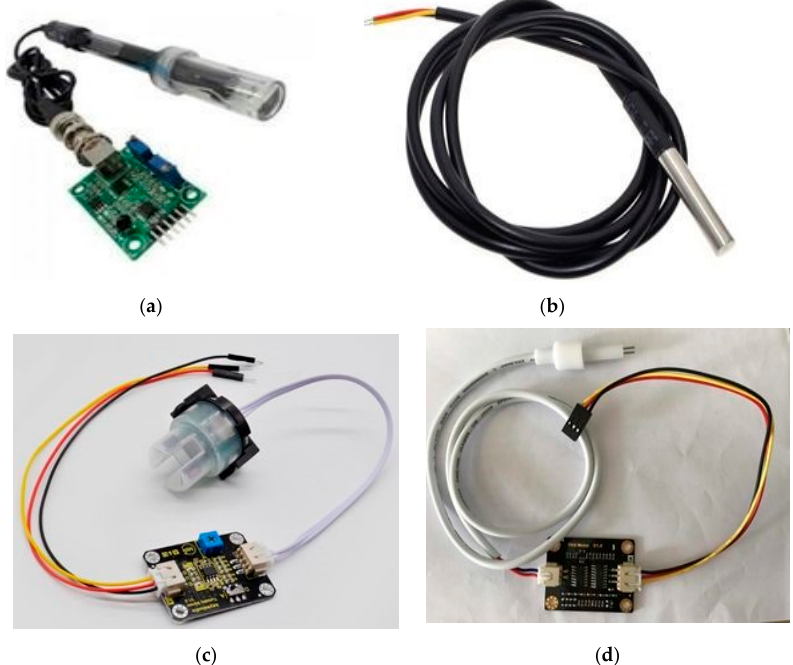
Figure 3. ( a ) pH sensor, ( b ) temperature sensor, ( c ) turbidity sensor, ( d ) total dissolved solids sensor.